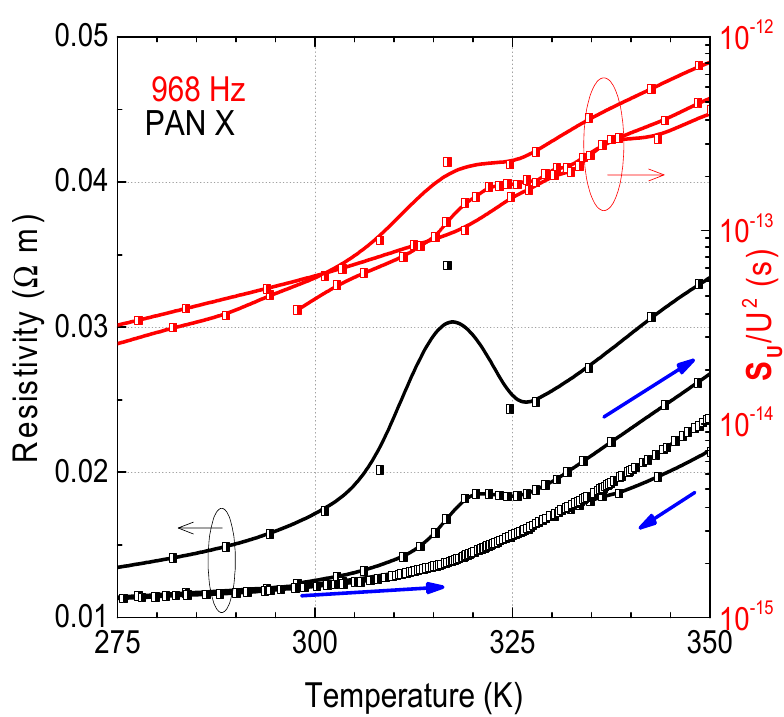
Figure 4. Dependencies of resistivity and voltage noise spectral density at 968 Hz of the PAN X sample on temperature at 31 mV (blue arrows indicate the directions of temperature changes).